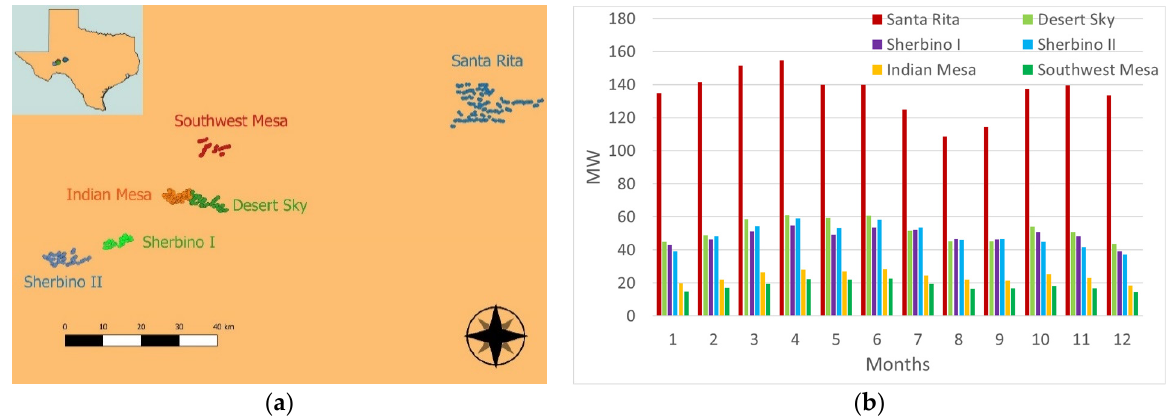
Figure 15. Six wind farms in central west Texas in close proximity to each other. ( a ) Map showing the configuration of the wind farms. ( b ) Monthly average power output in 1980–2018.